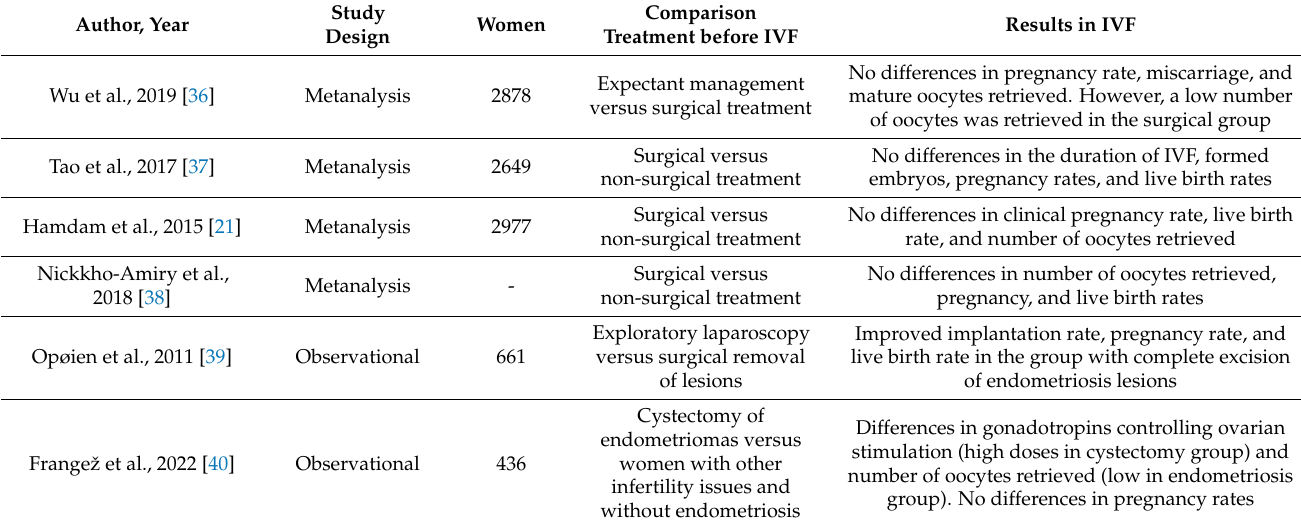
Table 6. Summary of the effectiveness of different treatments for women with endometriosis and in vitro fertilization (IVF) and reproductive and pregnancy